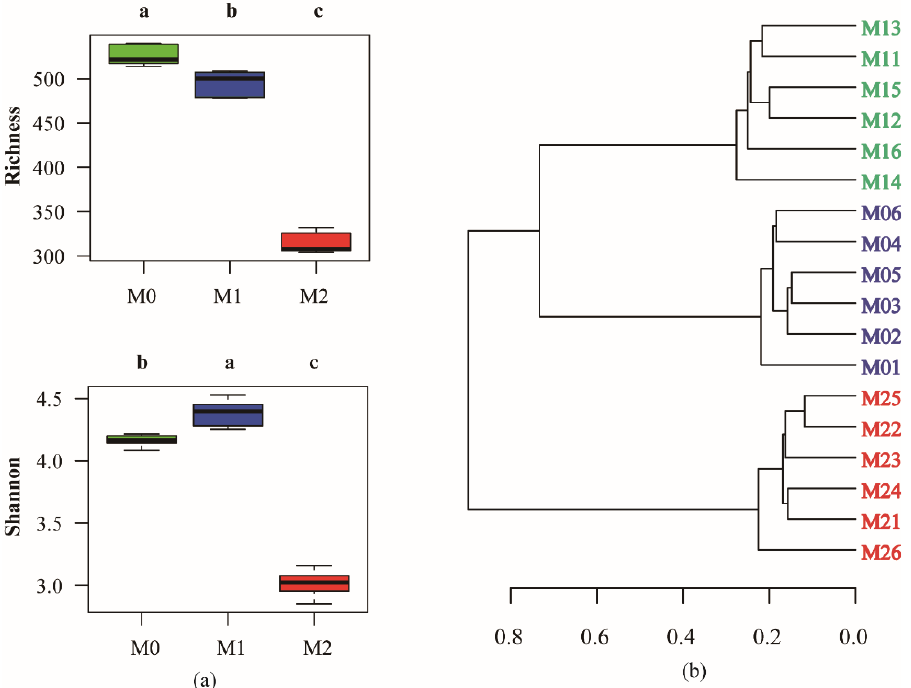
Figure 2. ( a ) Alpha-diversity indices of soil fungal community among three different management practices. Different letters indicate significant variation among the treatments according to one-way ANOVA (least significant difference [LSD], p ≤ 0.05, n = 6). ( b ) Hierarchical cluster diagram of soil fungal community. Blue, green, red numbers denotes the soil samples from undisturbed (M0), extensively managed (M1), and intensively managed (M2) bamboo plantations, respectively. Each group has six replicates.